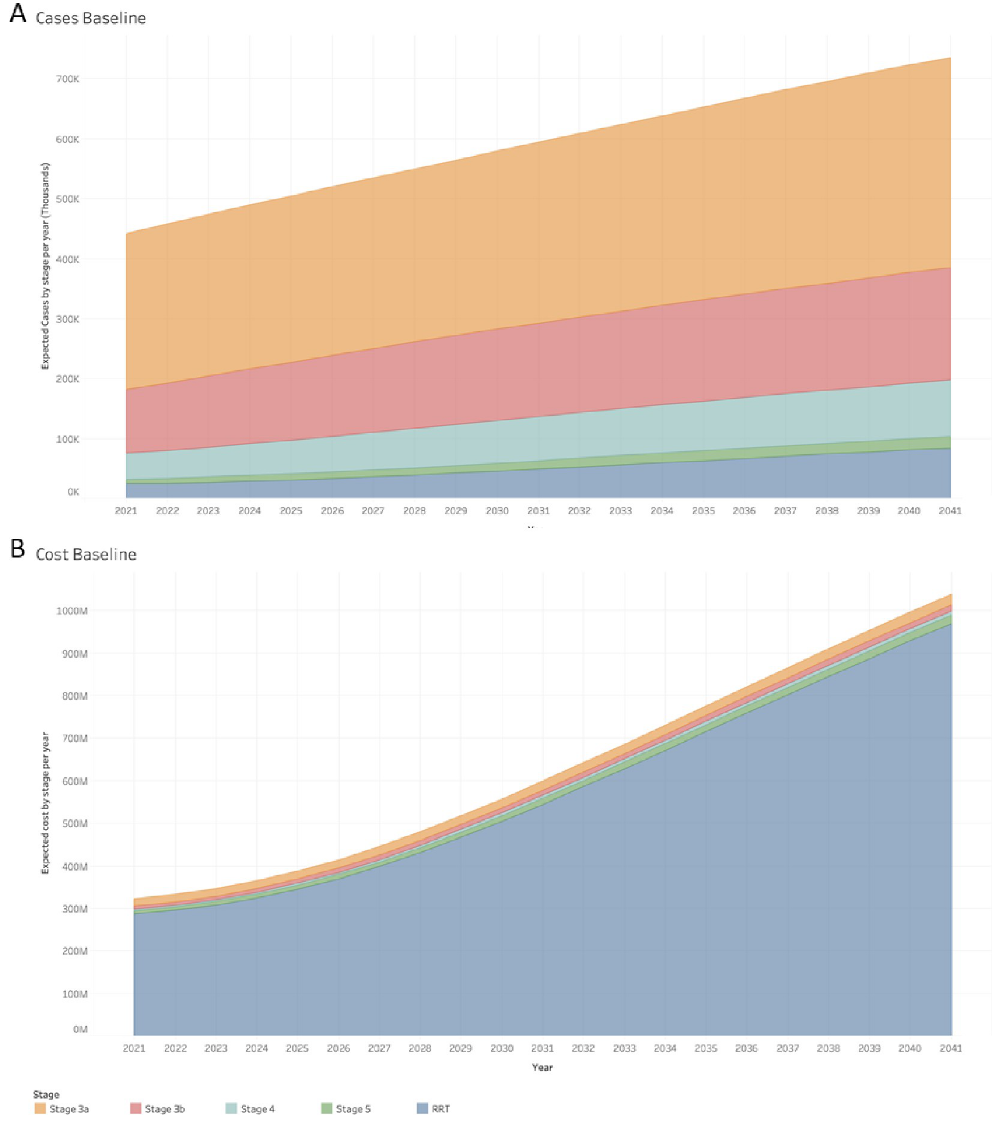
Fig 2. Expected number of cases and costs per year and CKD stage. Estimation of cases and costs of CKD to 2041. A: Estimation of cases of CKD by stage and year to 2041. B: Estimation of costs (in Million GBP) of CKD by stage and year to